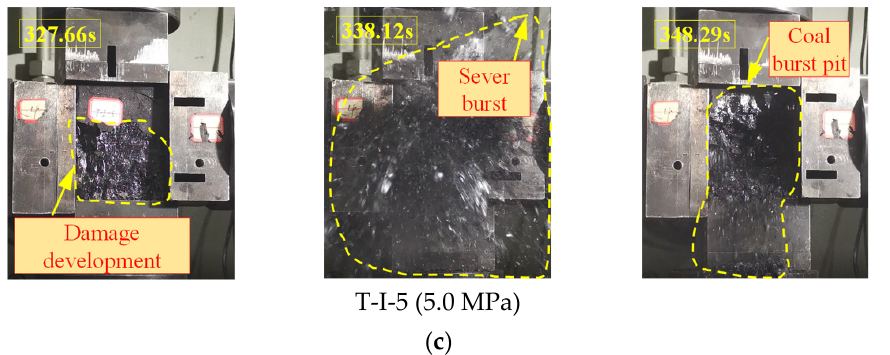
Figure 12. Typical impact failure characteristics of different mining disturbances: ( a ) static load; ( b ) cyclic load; ( c ) transient load.